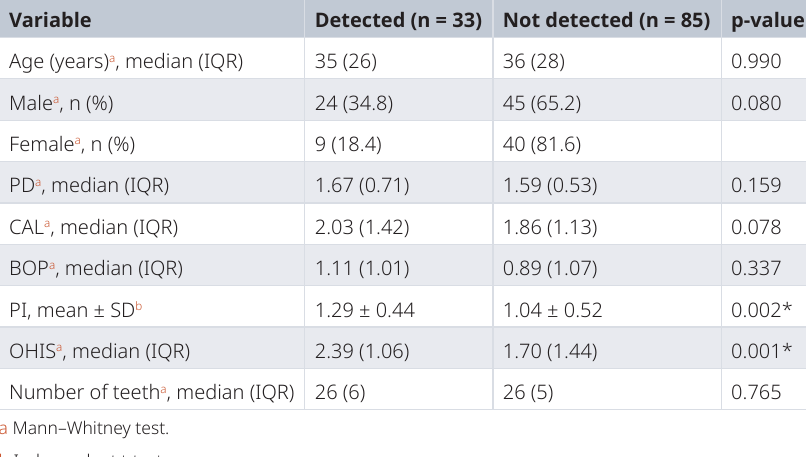
Table 3. Demographic data and clinical parameters in relation to detected EBV